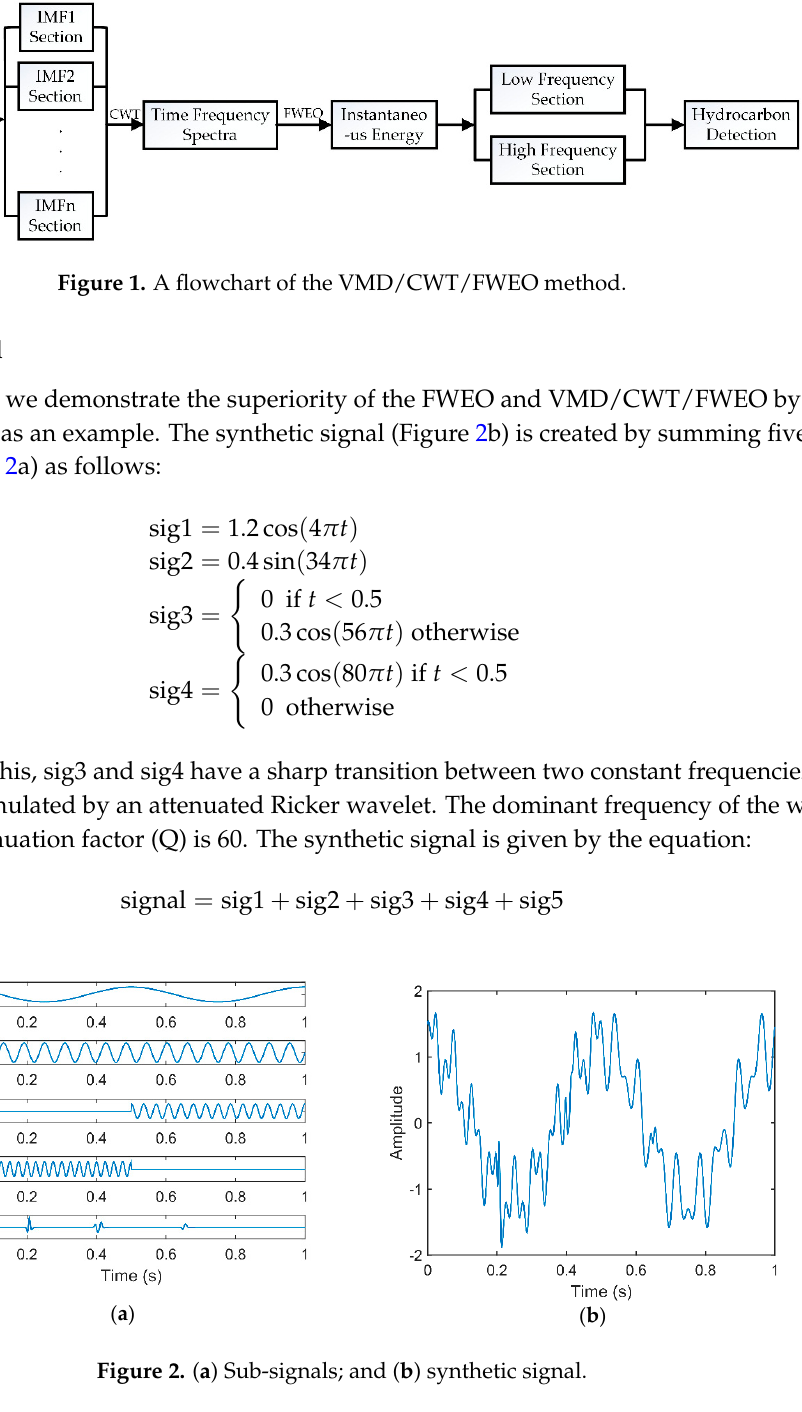
Figure 3. Instantaneous energy of the synthetic signal. Following this, FWEO and TK are utilized to calculate instantaneous energy for every frequency component of time-frequency spectra, allowing for the instantaneous spectra to be obtained. Figure 4a gives the results based on TKEO, while Figure 4b is the absolute values of those found in Figure 4a. Figure 4c shows the instantaneous energy results based on FWEO. We easily found that there are many negative values around 2 Hz in Figure 4a. Although there are no negative values in Figure 4b by the operation of absolute value, the operation has no physical basis and generates some false instantaneous information. However, the end-effect problem appearing in Figure 4b is resolved in Figure 4c by using the FWEO method, with the energy of the time-frequency spectrum in Figure 4c being more concentrated. Hence, the FWEO method can improve the time-frequency focusing